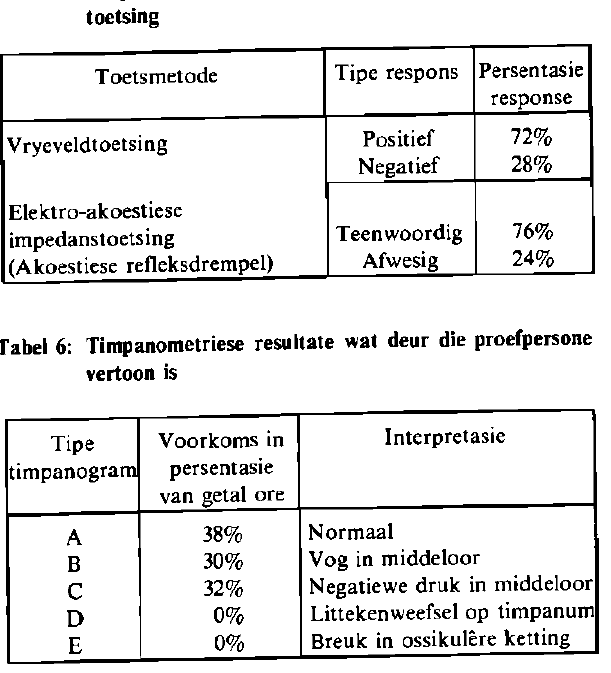
Tabel 5: Response van die proefpersone op pedo-oudiometriese